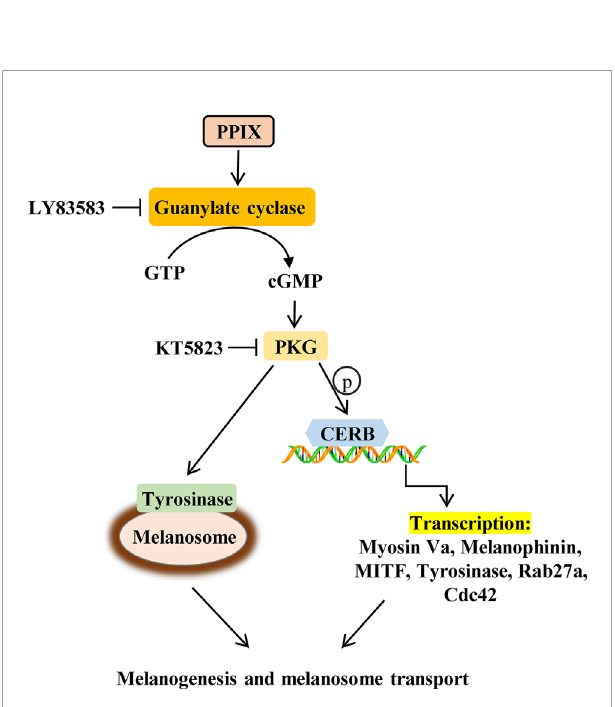
FIGURE 7 | Schematic description of changes in pigmentation upon PPIX